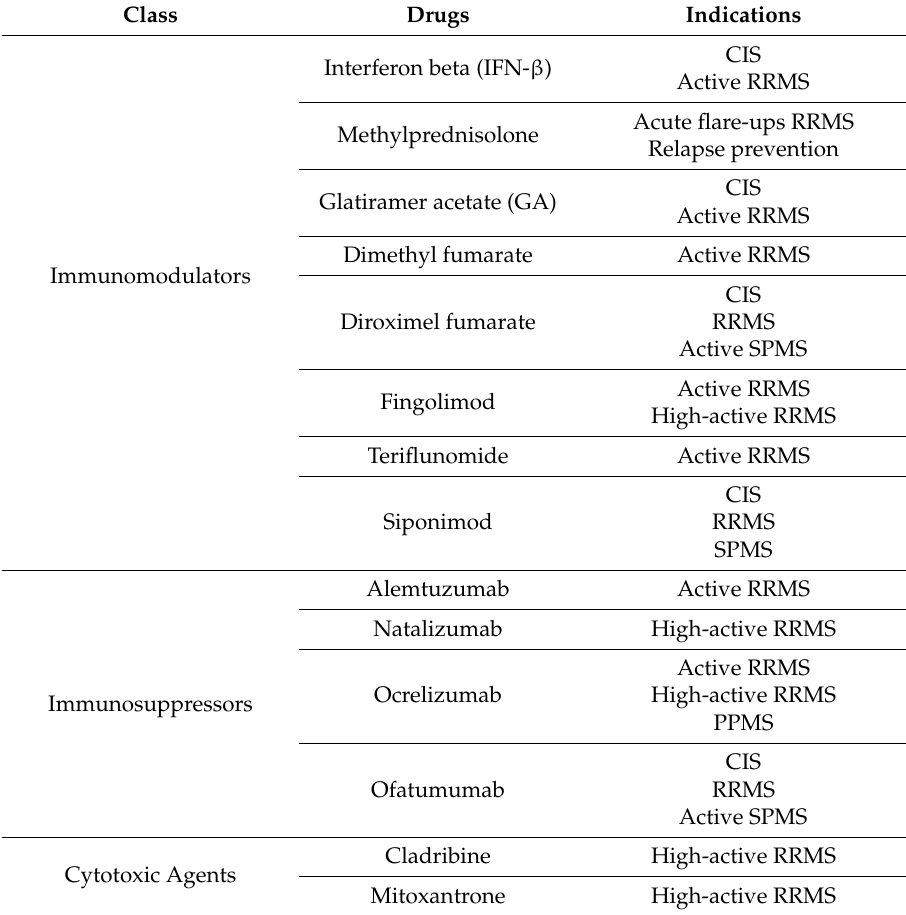
Table 1. Licensed disease-modifying drugs in multiple sclerosis